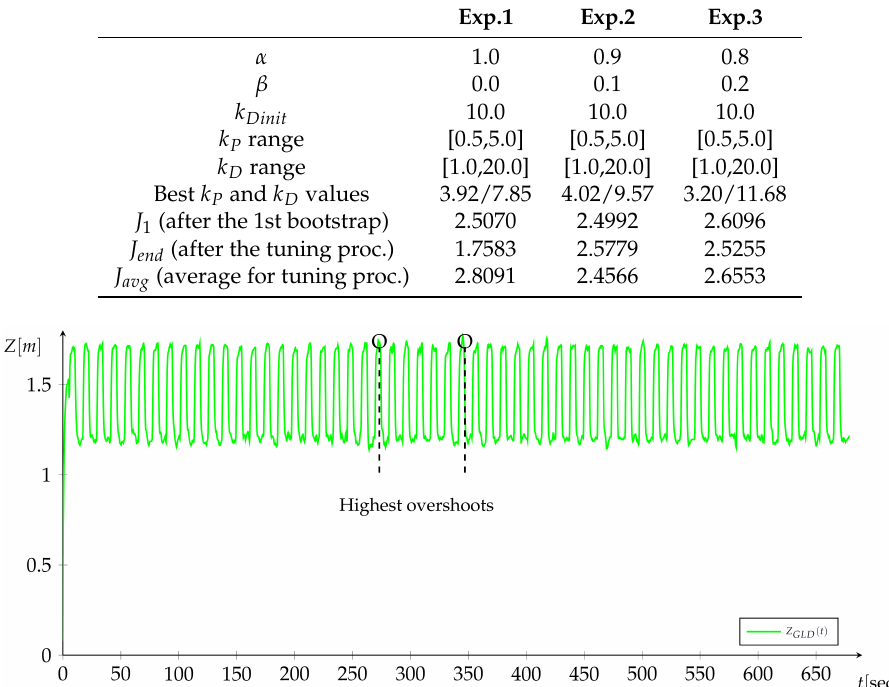
Figure 20. Time course from the tuning experiment via GLD method—variant: tuning of the altitude controller during the UAV flight with an additional (heavy) mass (225 g); the experiment interrupted due to the loss of